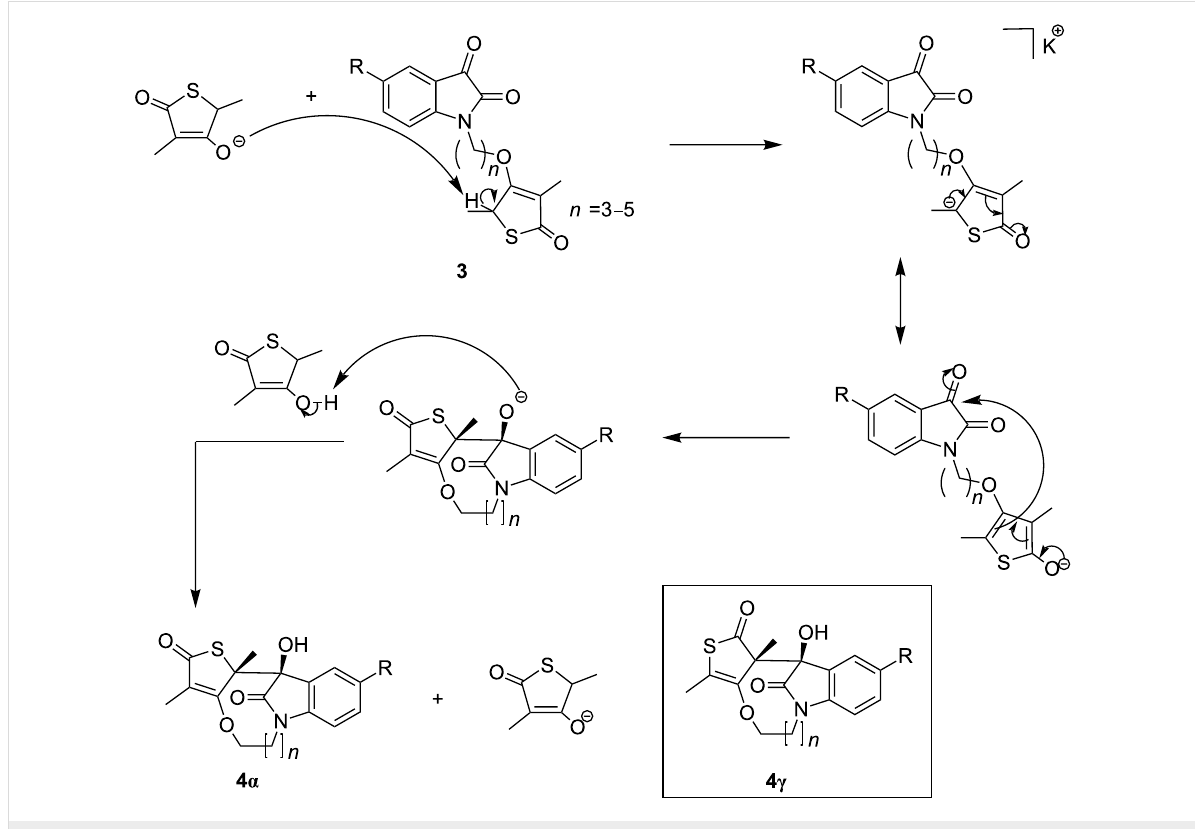
Scheme 2: Proposed mechanism for the formation of tetracycles 4 .